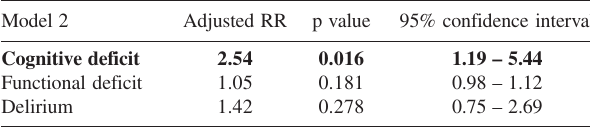
Table 3A - Cox regression model 2, excluding ARF